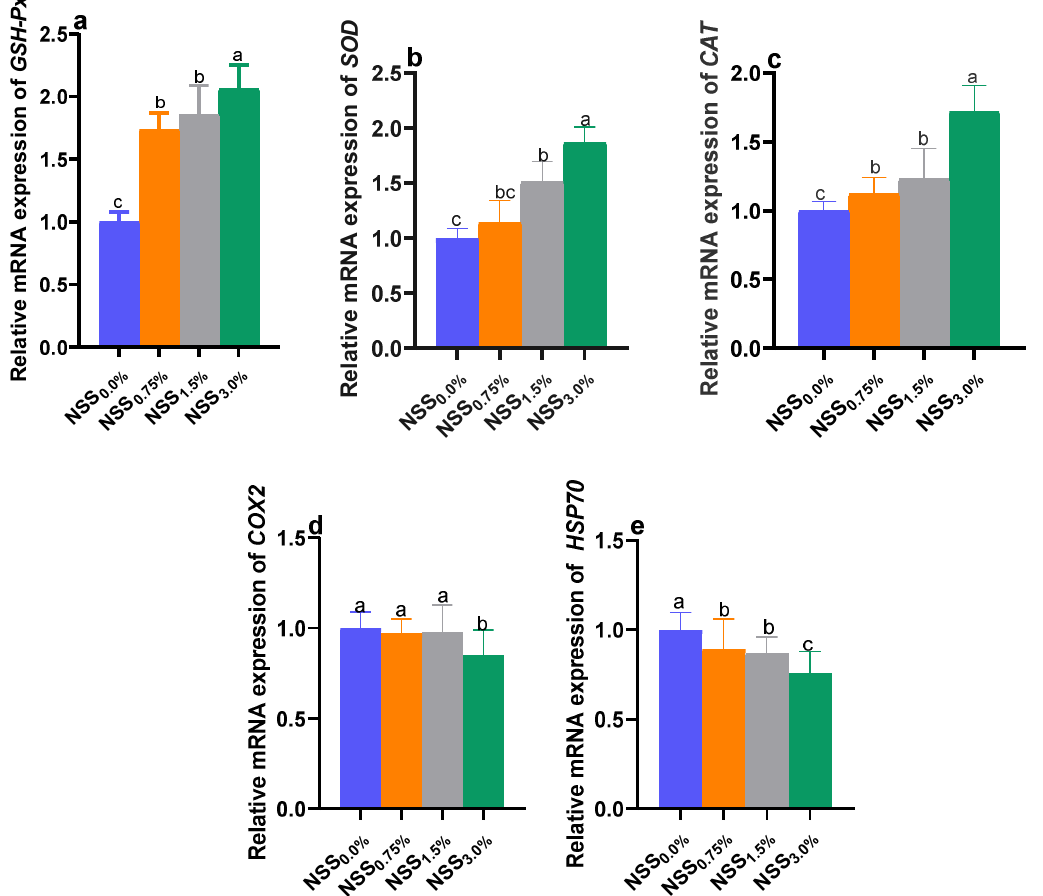
Figure 1. Effect of supplementing diets with varying levels of a microalgae mix (NSS) containing Nannochloropsis oculate and Schizochytrium and Spirulina species at equal proportions (1:1:1) for 12 weeks on relative expression of antioxidant-related genes; GSH-Px : glutathione peroxidase ( a ), SOD : superoxide dismutase ( b ) and CAT : catalase ( c ) and stress-related genes; COX-2 : cyclooxygenase-2 ( d ) and HSP70 : heat shock protein 70 ( e ) in Nile tilapia fillet. Data are expressed as means ± SE. Bars with different letters denote significant differences ( p < 0.05). NSS: microalgae mix containing Nannochloropsis oculate and Schizochytrium and Spirulina species at equal proportions (1:1:1), NSS 0.0% : control group fed basal diet free from NSS, NSS 0.75% : basal diet supplemented with 0.75% of NSS, NSS 1.5% : basal diet supplemented with 1.5% of NSS, NSS 3.0% : basal diet supplemented with 3% of NSS.